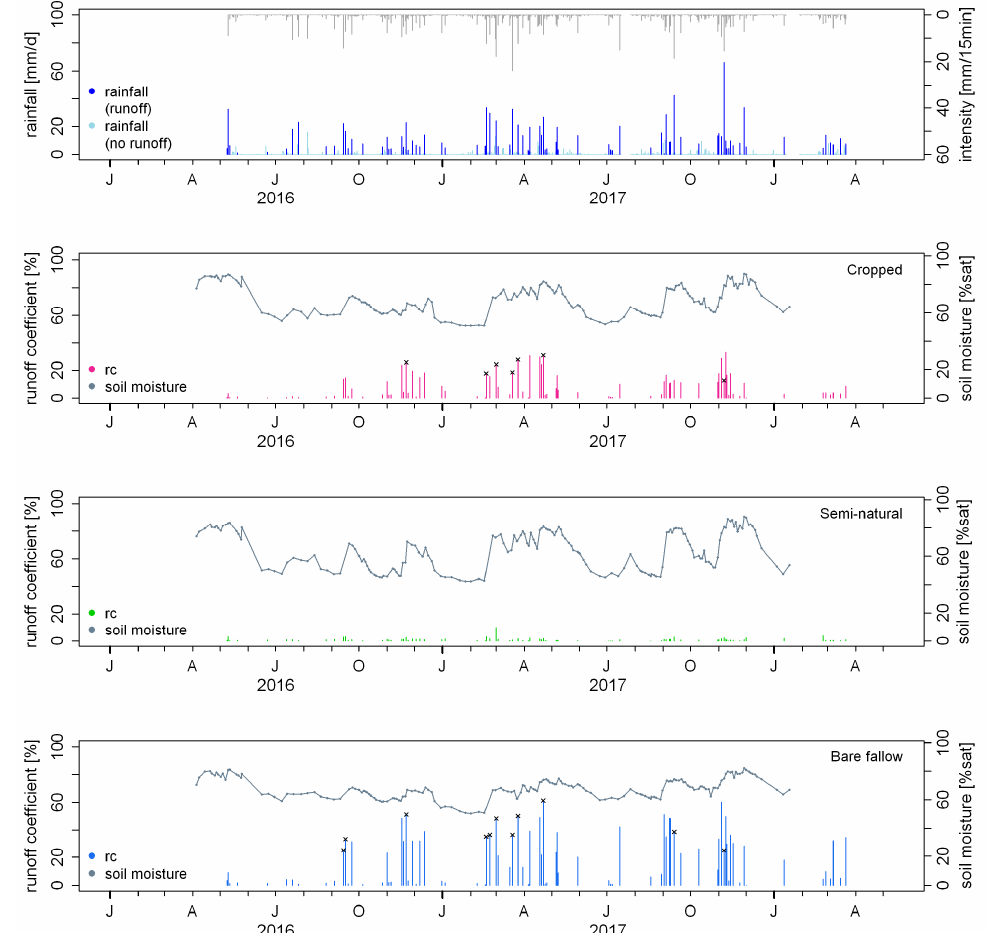
Figure 6. Daily rainfall (panel 1) and mean runoff coefficients on the plot under crop production, the plot under semi-natural vegetation, and the plot under bare fallow (panels 2–4, respectively). The dark lines represent the mean soil moisture at the slope under the respective land use type. The black × on top of a runoff bar indicates that the drums overflowed. The first panel depicts precipitation (light blue and blue bars) and rainfall intensity (grey bars). In this panel, the dark blue bars show rainfall amounts on days when surface runoff was generated, while the light blue bars show rainfall amounts when no surface runoff was generated. Timeline labeling “J A J O” refers to January, April, July, October.